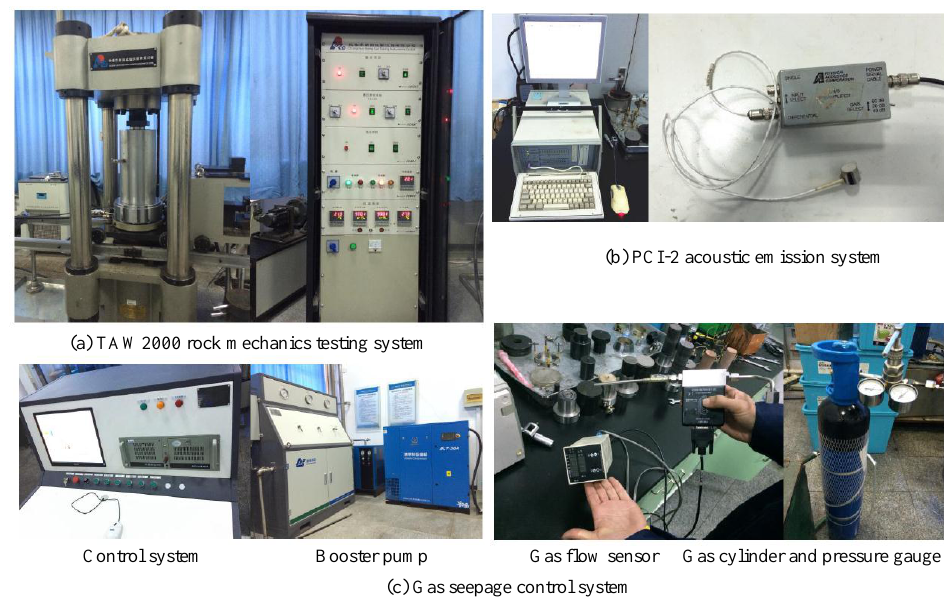
Figure 3. Images of the test equipment.